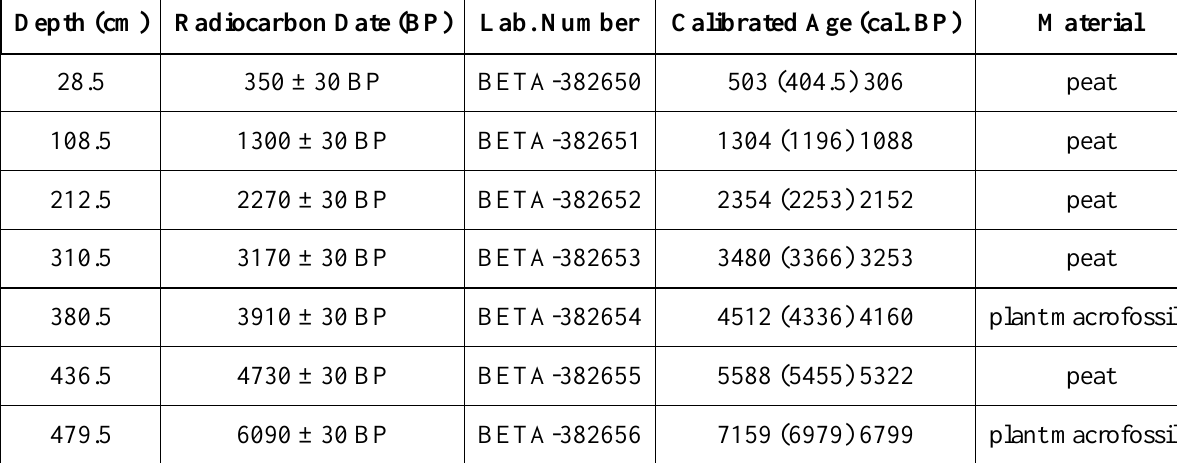
Table 1. Details of radiocarbon dating (depth, radiocarbon date, Beta Analytic Lab. Number, calibrated ages and material used). The radiocarbon dates were calibrated using OxCal version 4.2 (Ramsey 2009). All samples were dated using the fraction of plant material extracted from samples of peat by Beta